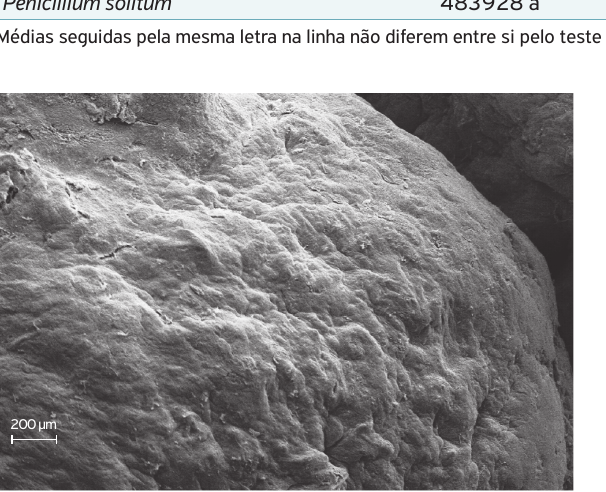
Figura 7. Eletromicrografia da superfície do grânulo de alginato de sódio com fungos imobilizados, sem a presença de micélio.